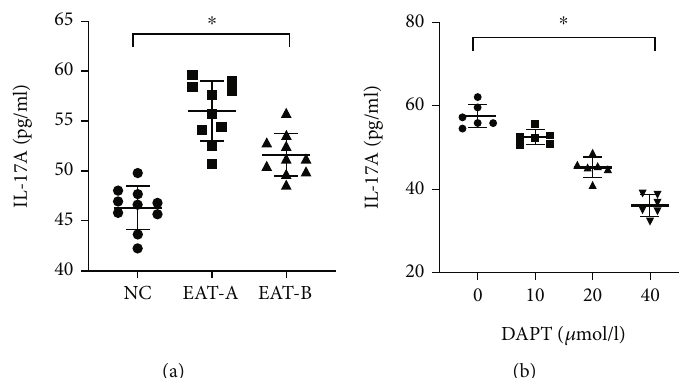
Figure 7: IL-17A concentrations in SMC culture supernatants in vivo and in vitro. (a) Altered levels of IL-17A in SMC culture supernatants. There were signi fi cant di ff erences among the three groups ( F = 38 : 882 , ∗ P < 0 : 001 , one-way ANOVA). EAT-B mice had lower IL-17A concentrations than EAT-A mice ( 51 : 62 ± 2 : 13 pg/ml vs. 56 : 02 ± 3 : 00 pg/ml , P < 0 : 001 ), and both EAT-A and EAT-B mice had higher IL-17A concentrations than NC mice ( 46 : 32 ± 2 : 16pg/ml , both P < 0 : 001 ). (b) Dose-dependent alterations of IL-17A levels in SMC culture supernatants after treatment with di ff erent concentrations of DAPT ( F = 86 : 750 , ∗ P < 0 : 001 , one-way ANOVA). 75 r = 0.931 P < 0.001